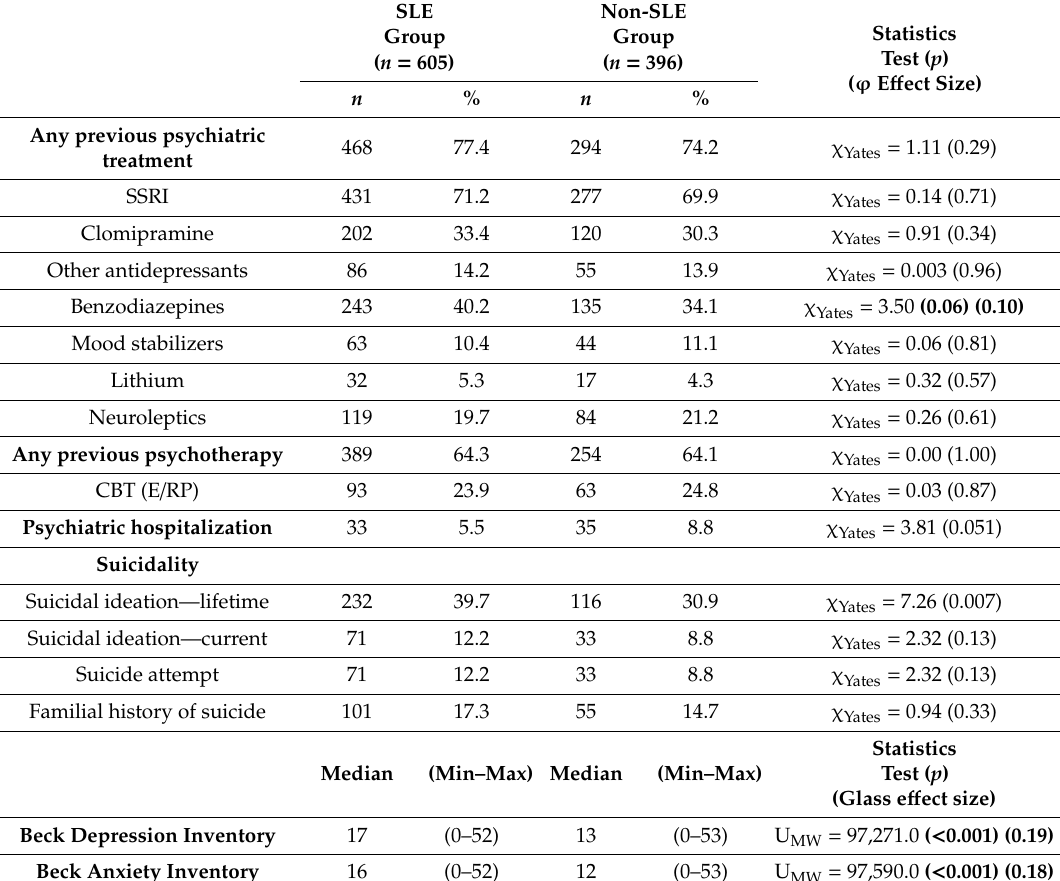
Table 3. Comparison of the extrinsic features of psychopathological OCD between the SLE and non-SLE